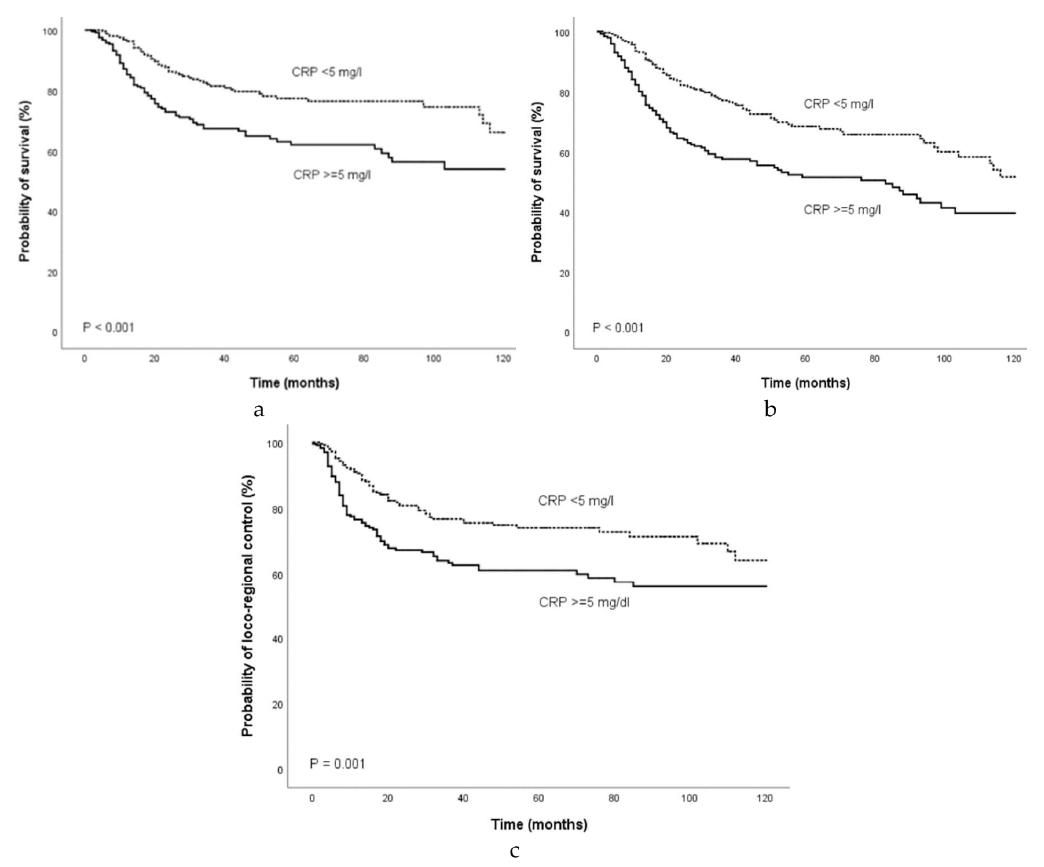
Figure 1. Kaplan-Meier curves for ( a ) cancer-specific survival, ( b ), overall survival, and ( c ) loco-regional control categorized by the pre-treatment CRP level. Abbreviation: CRP, C- reactive protein.